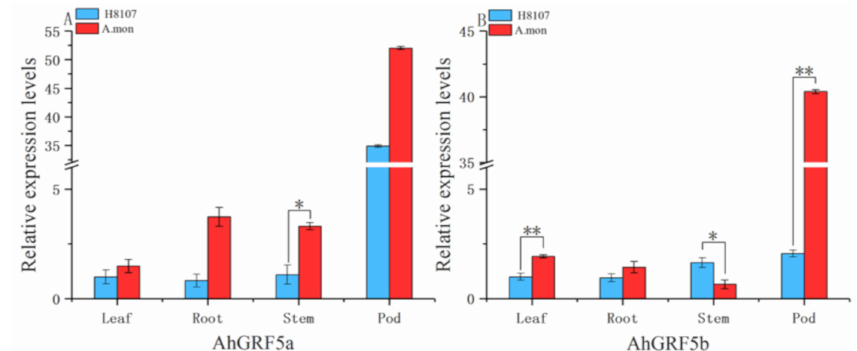
Figure 5. Expression analysis of AhGRF genes in di ff erent tissues. The qRT-PCR analysis of AhGRF s transcript levels was performed on leaves, roots, stems and pods. ( A ) AhGRF 5a and ( B ) AhGRF 5b. Experiments were repeated three times and vertical bars indicate standard errors. * and ** represent significant di ff erences at p < 0.05 and p < 0.01,